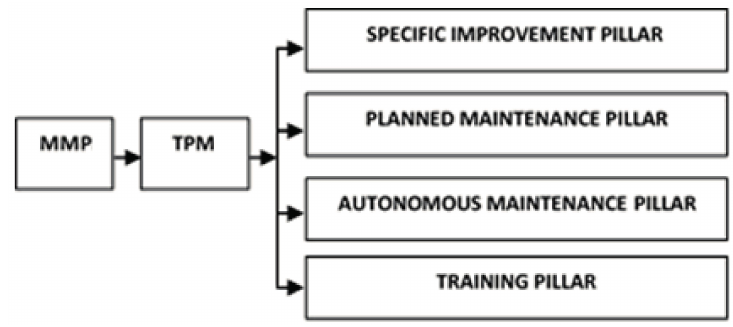
Figure 9. Total Productive